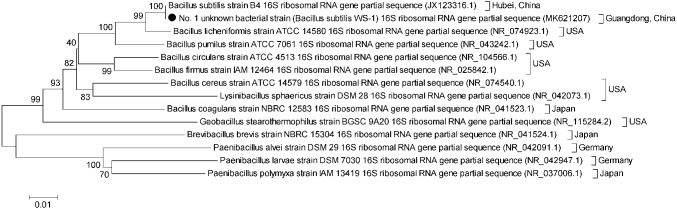
Phylogenetic tree constructed on the basis of the 16S rRNA gene from B. subtilis strain WS-1 and 13 B. subtilis strains from different countries. The dendrogram was constructed using the neighbor joining method in the MEGA software package, version 5. Reference sequences obtained from GenBank are indicated by strain name. The scale bar represents 0.01 nucleotide substitutions per site.